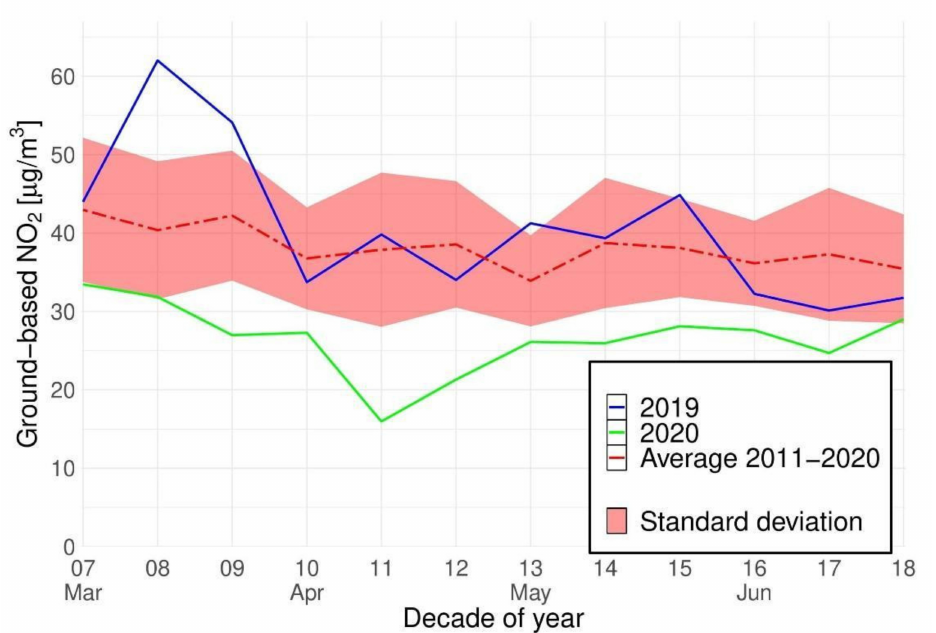
Figure 10. Mean decadal ground-based NO 2.5 concentrations ( µ g/m 3 ) from three GIOS air quality stations located in Warsaw in 2019 (blue line), 2020 (green line) and the 10-year multi-annual average (dashed red line). Standard deviations corresponding to multi-annual averages are marked in